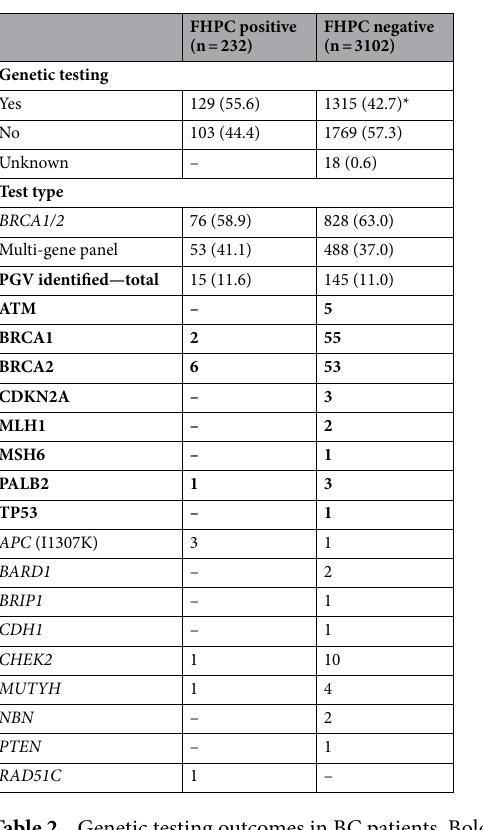
Table 2. Genetic testing outcomes in BC patients. Bold area represents genes with PC screening recommendations. *p <